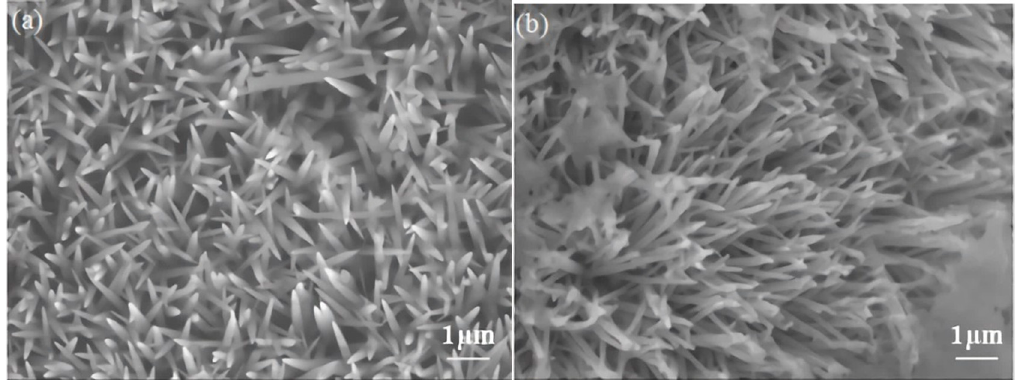
Figure 2. ( a ) FESEM image of NCO nanorod arrays and ( b ) FESEM image of NCS nanotube arrays on Ni foam.